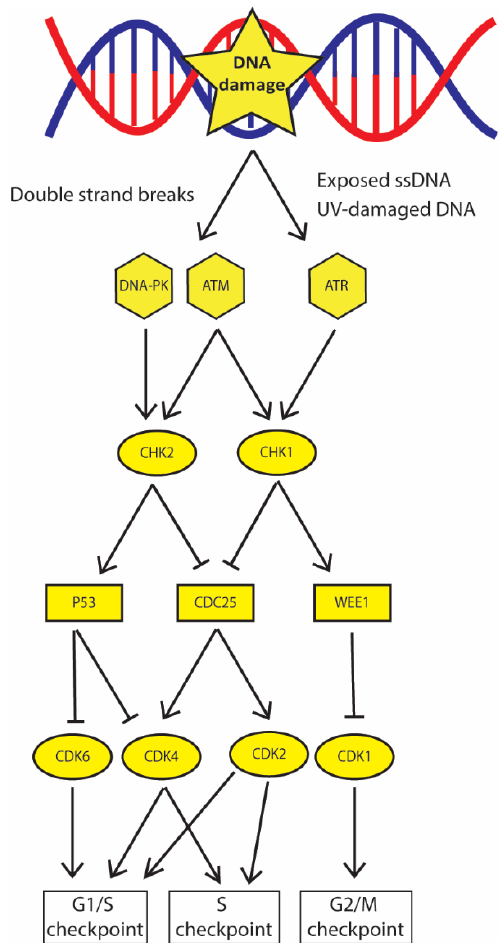
Figure 1. DDC signaling cascade determines arrest in specific phases of the cell cycle. ATM, DNA-PK, and ATR phosphorylate the downstream kinases CHK2 and CHK1; in turn they activate P53 and WEE1 that, by inhibiting CDK6/4 and CDK1 determine arrest in G1 and G2/S, respectively. CHK1 and CHK2 also inhibit CDC25 phosphatase that does not remove inhibitory phosphate groups from CDK2/4, therefore determining arrest in the S phase.